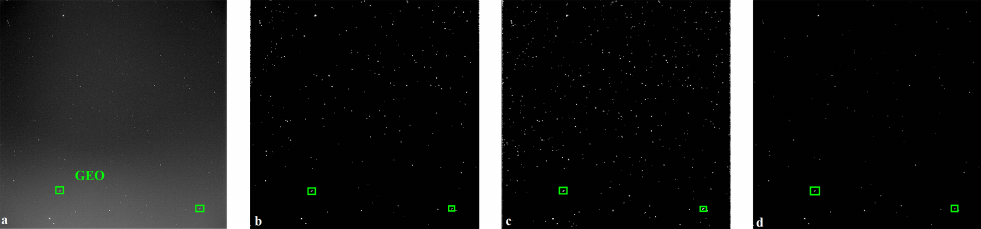
Figure 12. Italian Space Agency Matera Telescope’s image segmentation: ( a ) real image; ( b ) LTA’s prediction; ( c ) LTS’ prediction; ( d ) the BOSS algorithm’s prediction.